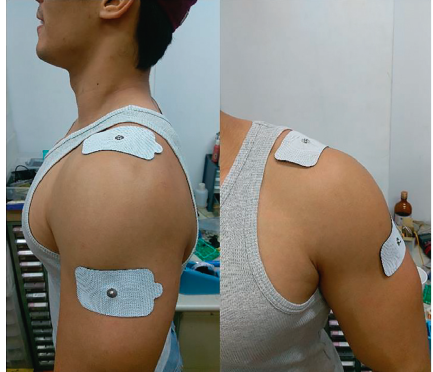
Figure 2: Electrical pad placement: one electrical pad (9cm × 5cm) attached at the maximally tender area. The other pad was attached at the inferior margin of the deltoid muscle on the same